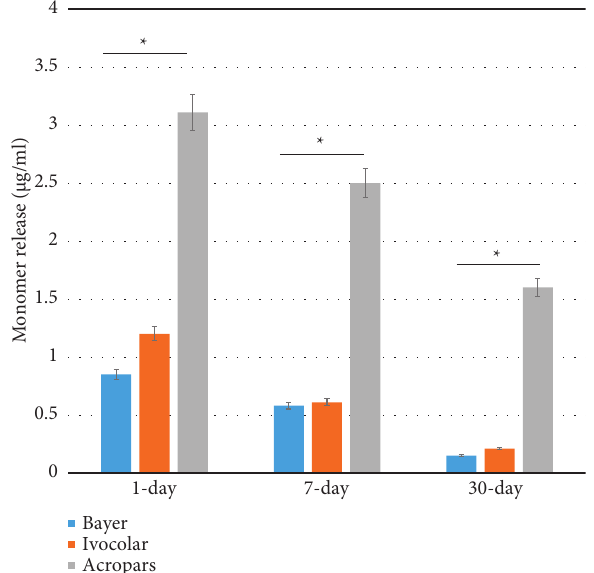
Figure 2: The amount of monomer release ( μ g/ml) is categorized by the type of acrylic resin.